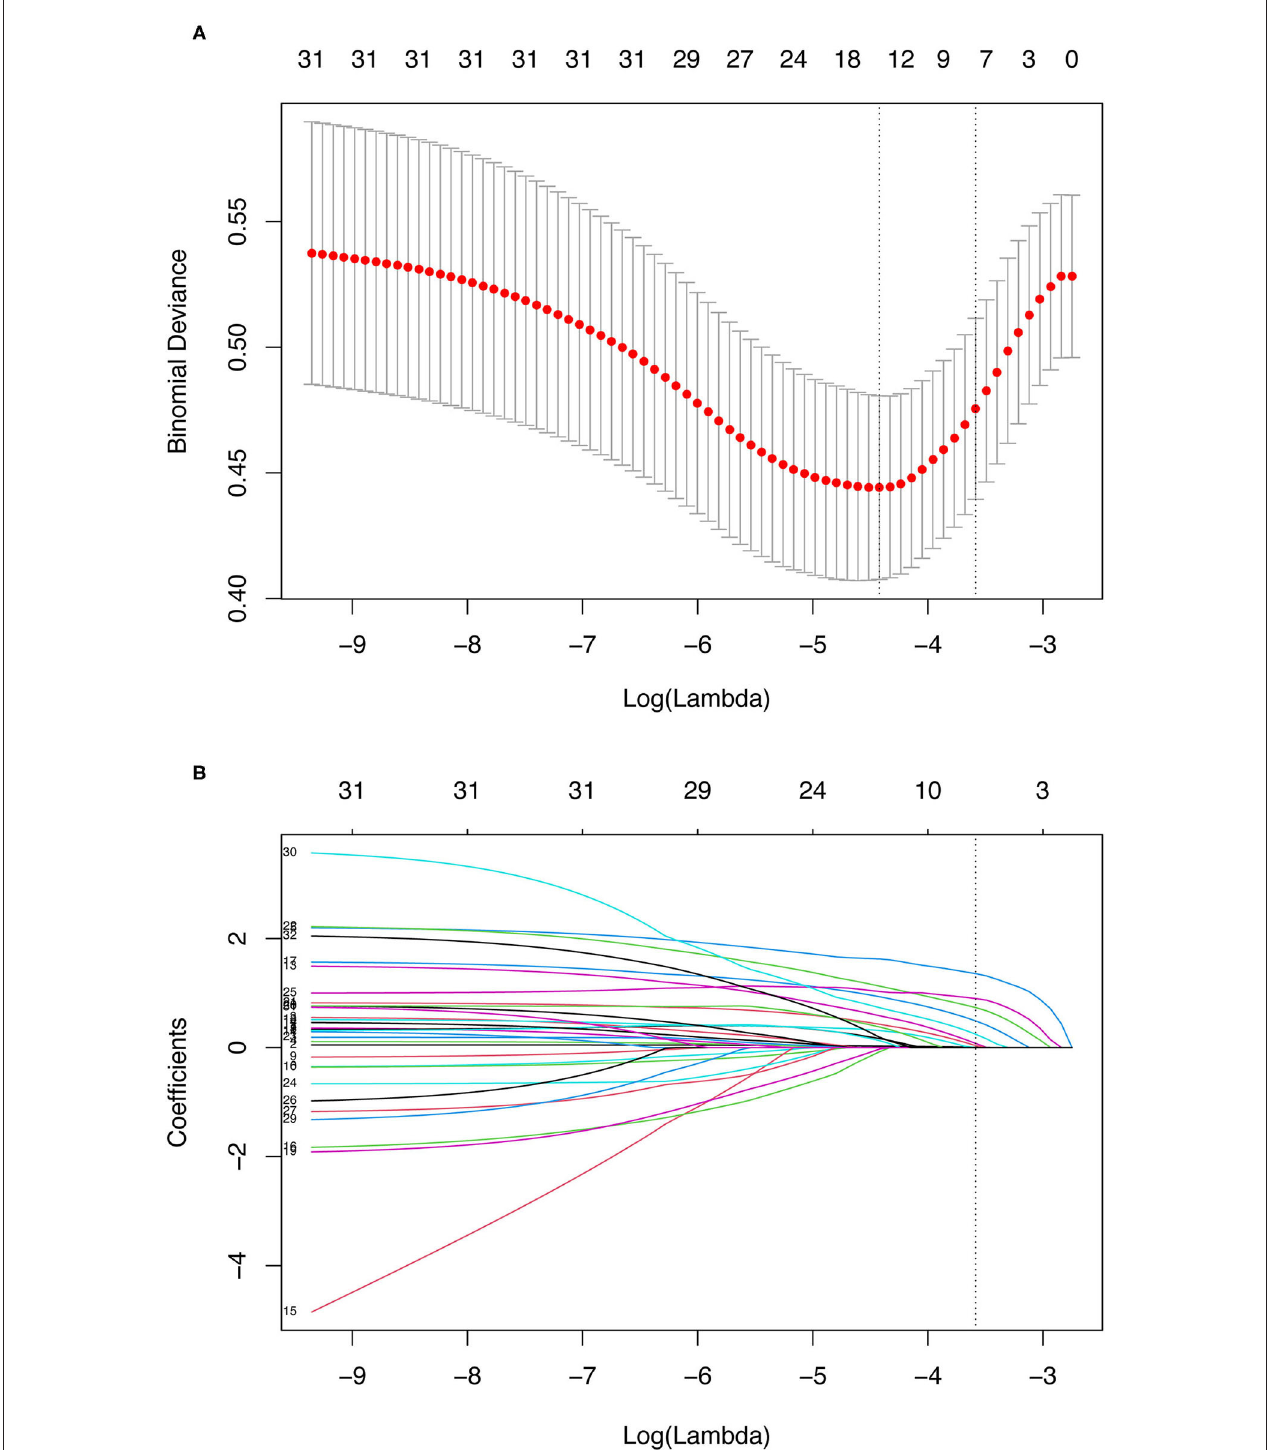
FIGURE 1 | Demographic and clinical variables selection using the LASSO binary logistic regression model. (A) Optimal parameter (lambda) selection in the LASSO model used tenfold cross-validation via minimum criteria. The binomial deviance curve was plotted vs. log(lambda). Dotted vertical lines were drawn at the optimal values by using the minimum criteria and the 1 SE of the minimum criteria (the 1-SE criteria). (B) LASSO coefficient profiles of the 31 variables. A coefficient profile plot was produced against the log(lambda) sequence. A dotted vertical line was drawn at the value selected using tenfold cross-validation, where optimal lambda (with the 1-SE criteria) resulted in eight predictive variables the same as variables selected by the stepwise regression method. LASSO, least absolute shrinkage and selection operator; SE, standard error.